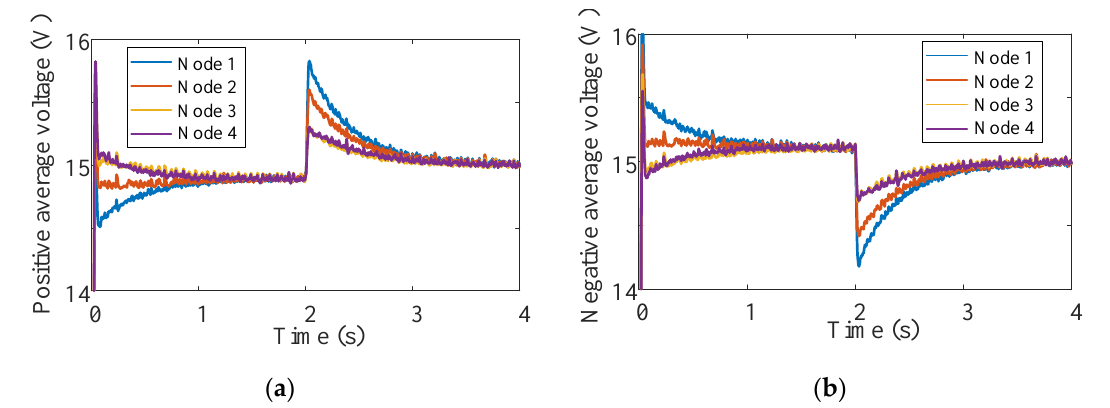
Figure 11. The effect of distributed consensus control combining primary control and secondary control on the average voltage of the ( a ) positive bus and ( b ) negative bus.